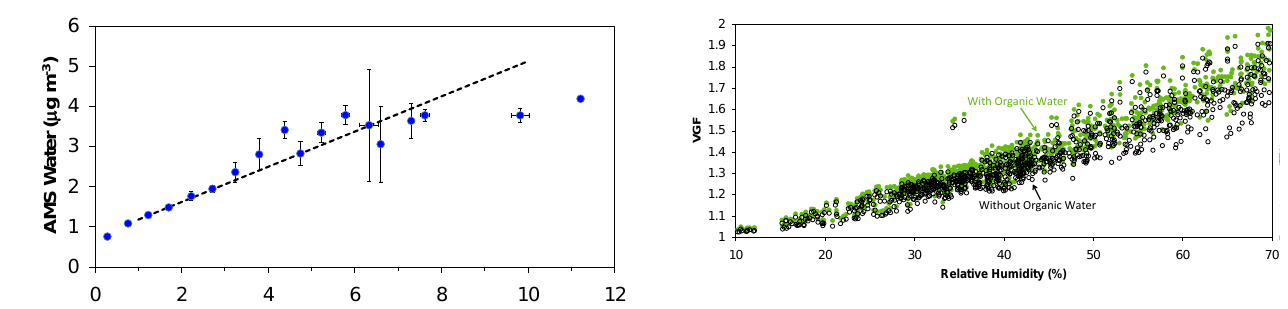
Fig. 8. Predicted volume growth factor versus RH predicted from the E-AIM model using only inorganics (black) and including water uptake from organics estimated from Koo et al. (2003)